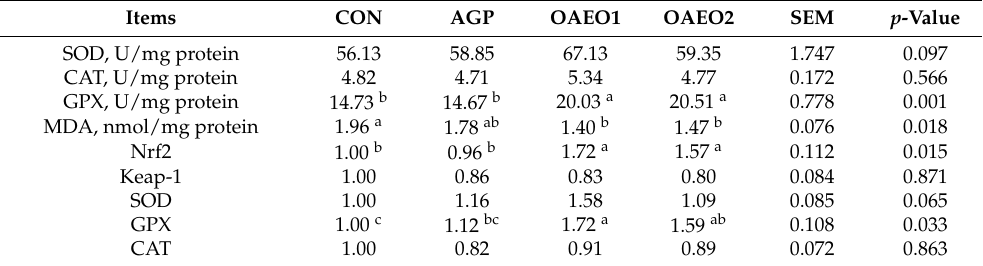
Table 6. Effect of OAEO on intestinal antioxidant status and Nrf2 signaling pathway-related gene mRNA levels of weaned piglets.